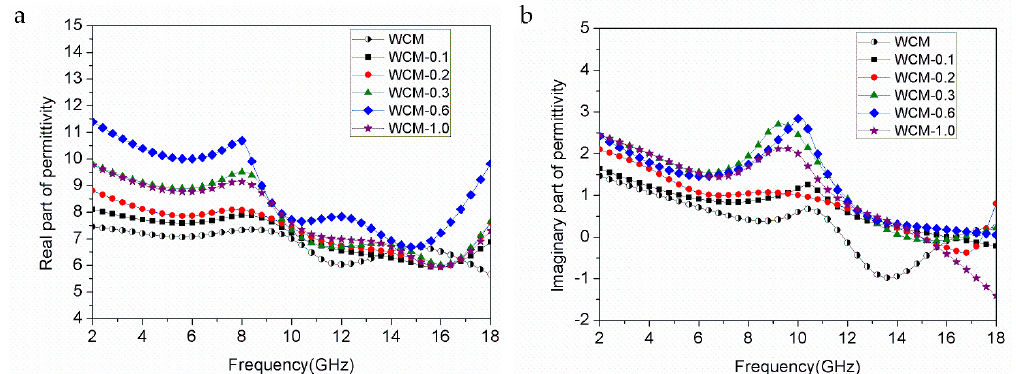
Figure 4. Complex permittivity of α-Fe/Fe 3 C/woodceramic nanocomposites as a function of frequency ( a ) real part of permittivity; ( b ) imaginary part of permittivity.